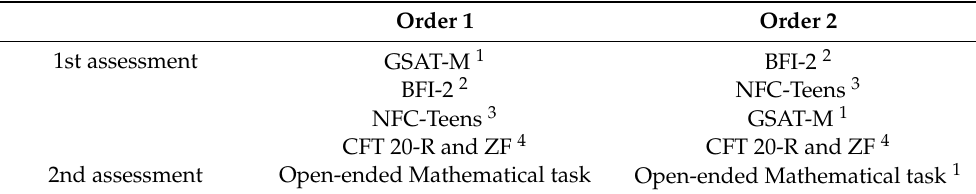
Table 2. Procedure of the data collection within the mathematical talent search 2021. Order